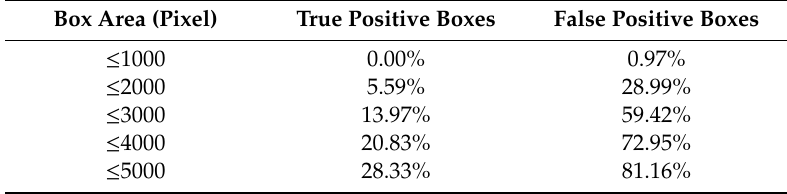
Table 5. Cumulative relative frequency of true positive and false positive boxes of box